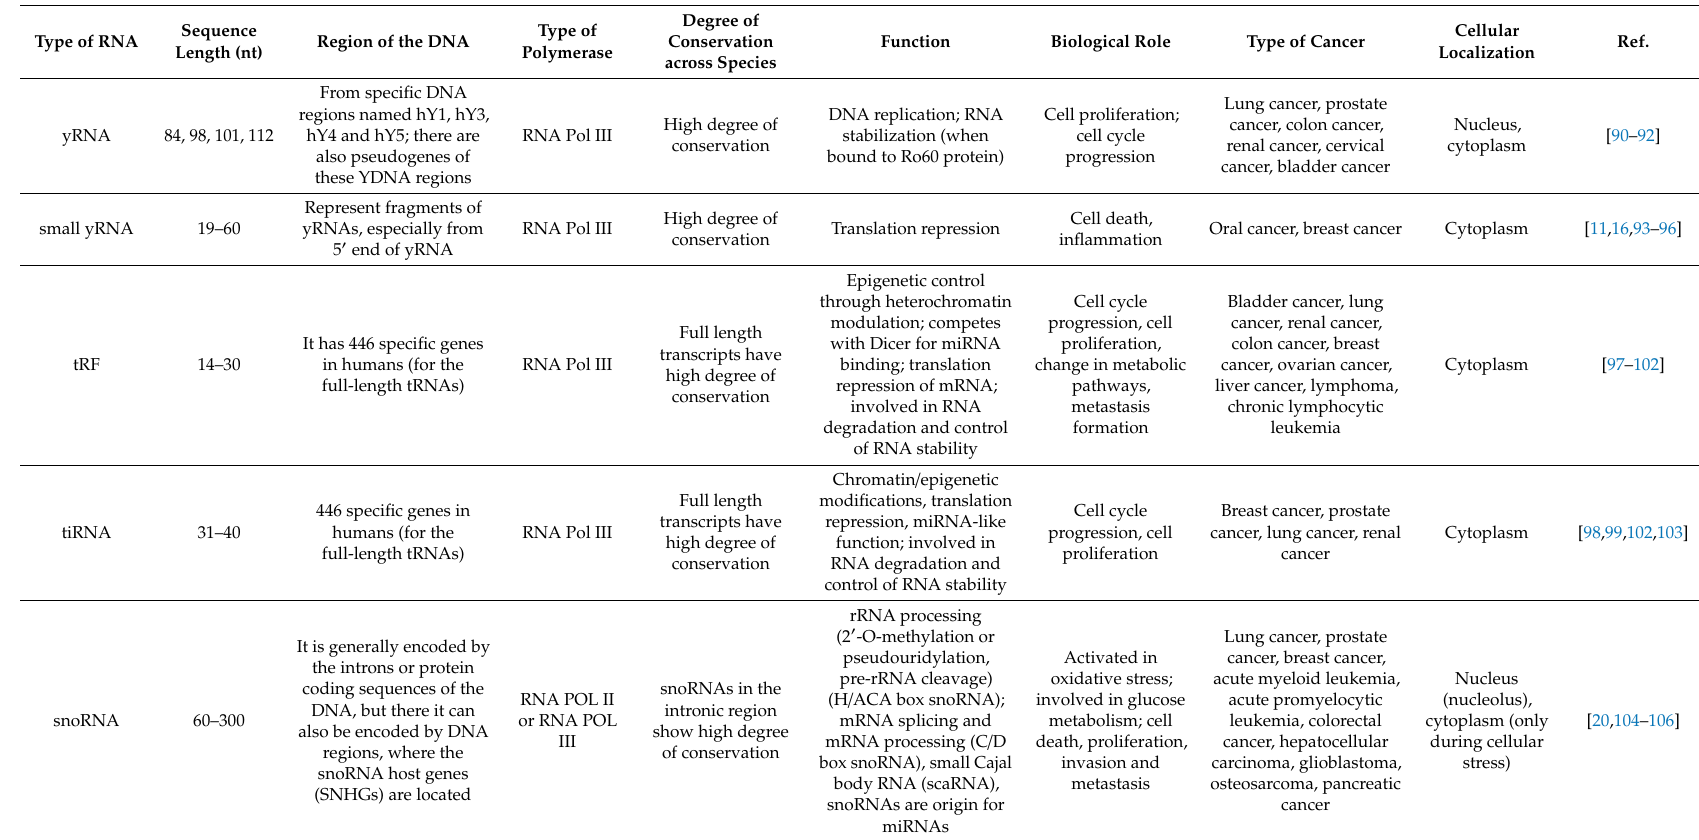
Table 1. Characteristics of rare RNA species included in the present narrative